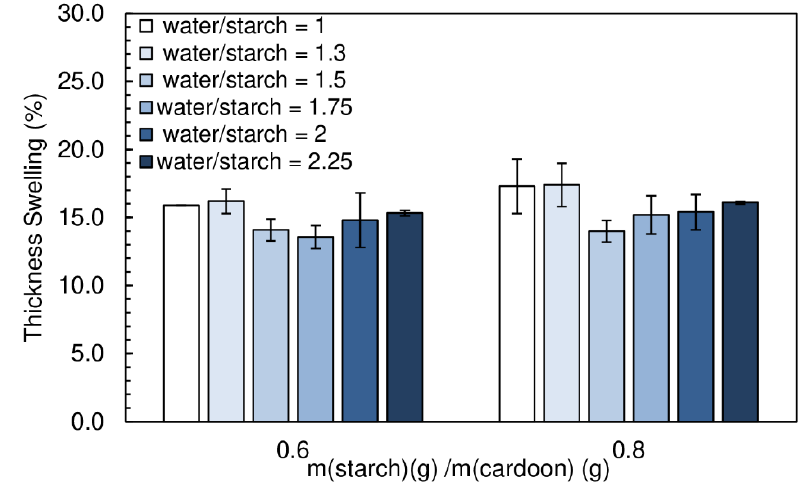
Figure 15. Effect of water content on thickness swelling of the particleboards bonded with a potato starch. All adhesive formulations had a starch / cardoon ratio of 0.6 and 0.8 and cs / starch ratio of 0.05.